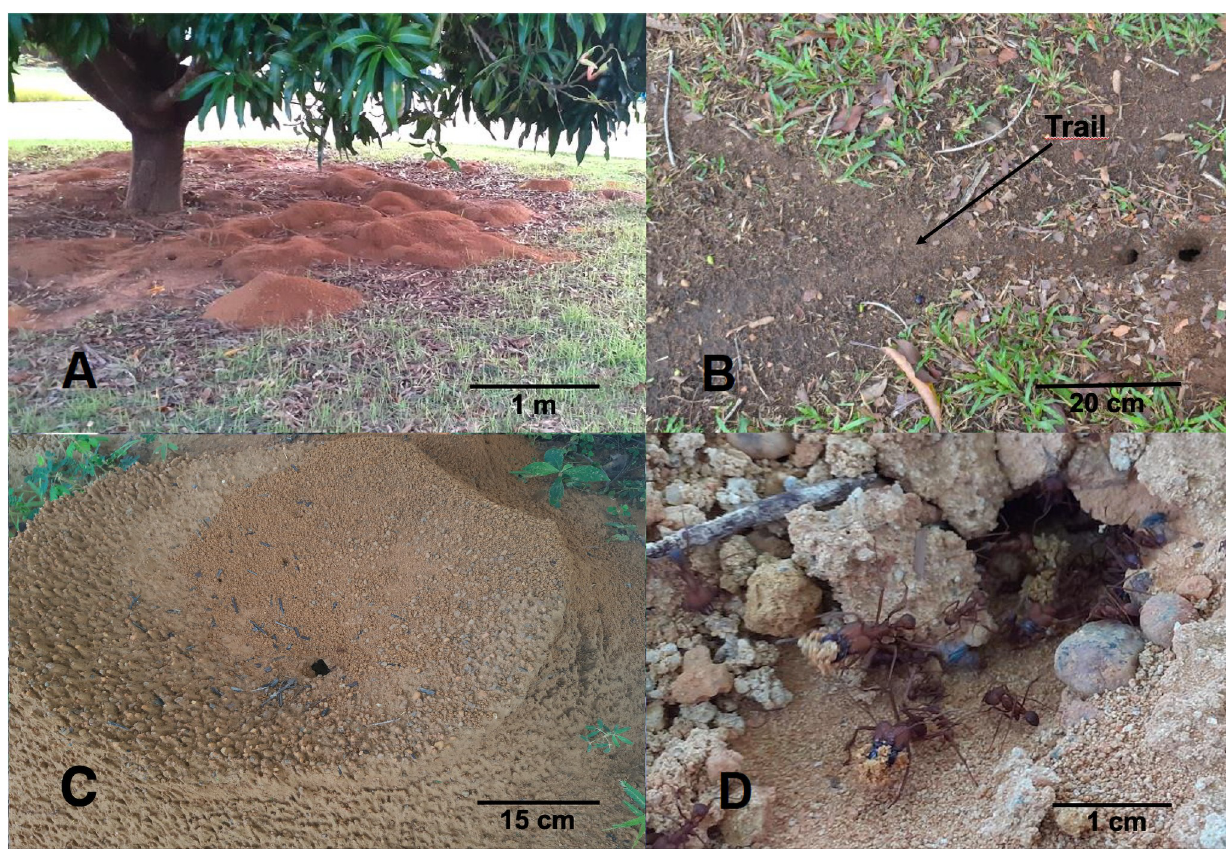
Fig 1. A : Atta laevigata nest; B : Supply orifice with foraging trail; C : A crater with an orifice in the center; D : Details of excavator workers carrying pellets (mixture of soil, humus and litter) with their mandibles. Photos: M.L.O. Souza.